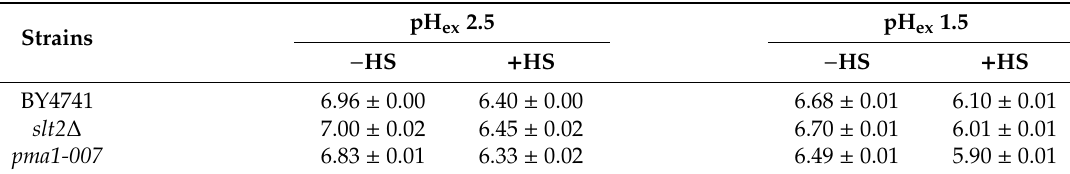
Table 2. E ff ects sorbic acid (HS) addition in LOFLO medium adjusted to 2.5 or 1.5 (pH ex ) with sulphuric acid on the cytosolic pH (pH c ) of the S. cerevisiae wild type strain BY4741 and its isogenic mutants slt2 ∆ and pma1-007 . Numbers represent average ± standard deviation of three biological replicates.